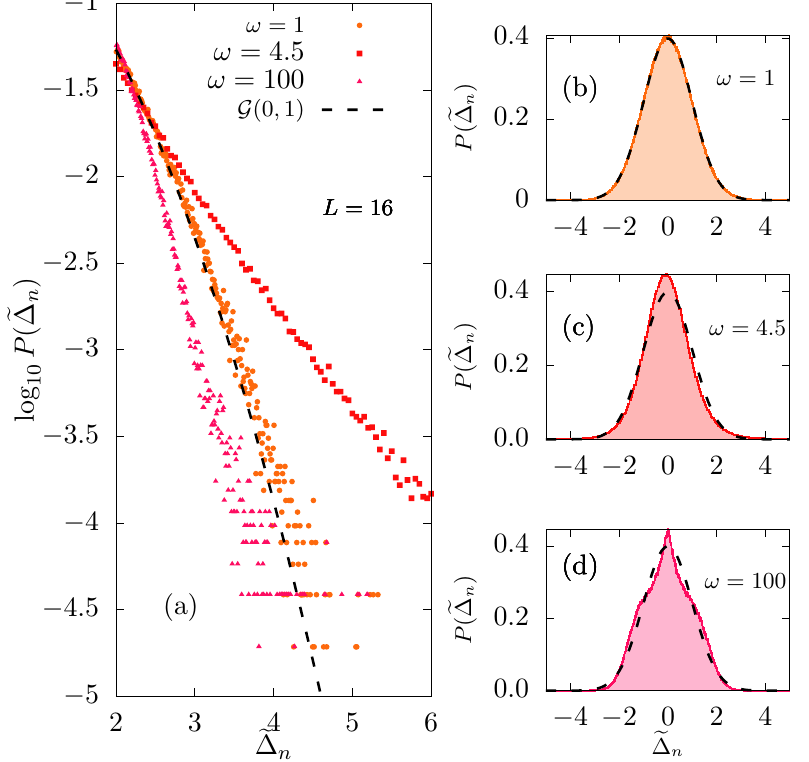
) , for L = 16 and disorder values , P ( (cid:101) ∆ n n